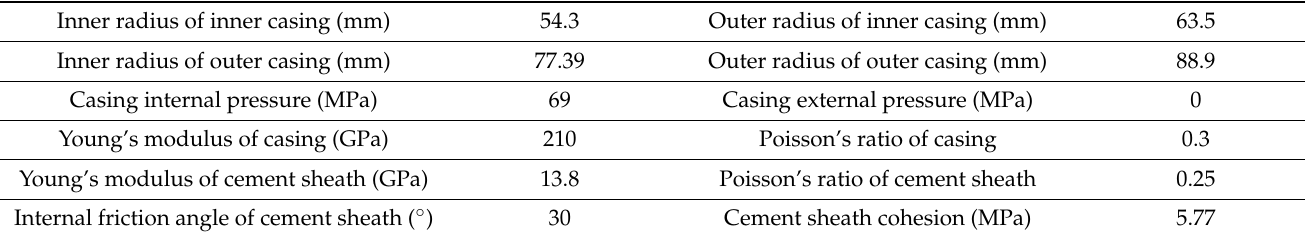
Table 1. Parameters in Jackson et al.’s experiment and Chu et al.’s theoretical calculation